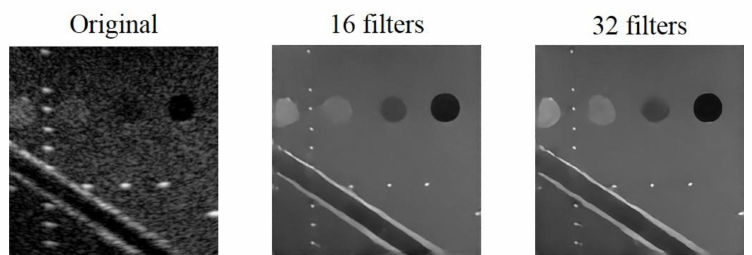
Figure 6. Original B-mode image and the reconstructed echogenicity maps of the mixed loss model when the minimum number of filters are 16 and